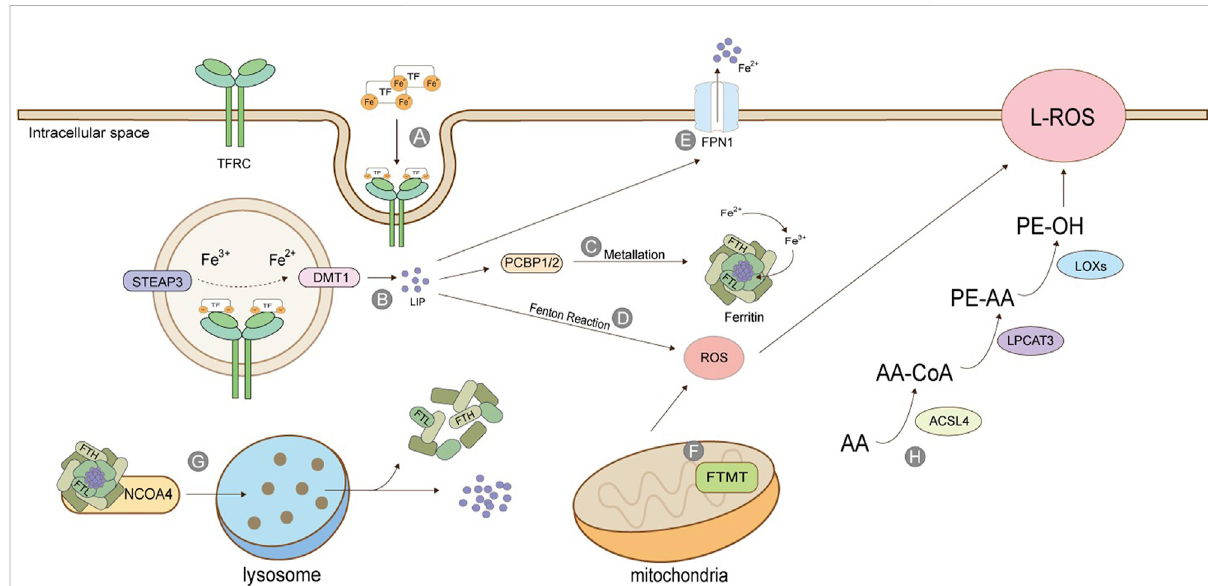
FIGURE 2 Production of Lipid Peroxide. (A) TF binds to TFRC and enters cells in the form of endosomes; (B) STEAP3 reduces Fe3+ to Fe2+, which is released into thecytoplasm byDMT1to form labile iron pool; (C) Under theactionof PCBP, the freeiron istransferred to ferritin, which is composed of heavy chain FTH and light chain FTL, and has the activity of iron oxidase, oxidizing Fe2+ into Fe3+ and stores it; (D) Iron ion-mediated Fenton reaction; (E) Excessive iron ions are transported extracellularly by FPN1; (F) Mitochondrial ferritin; (G) Iron autophagy process; (H) Lipid peroxidation. The fi gure modi fi ed from (Dev and Babitt,